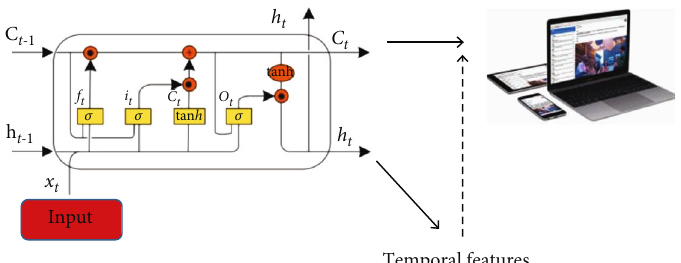
Figure 3: The working principle of the